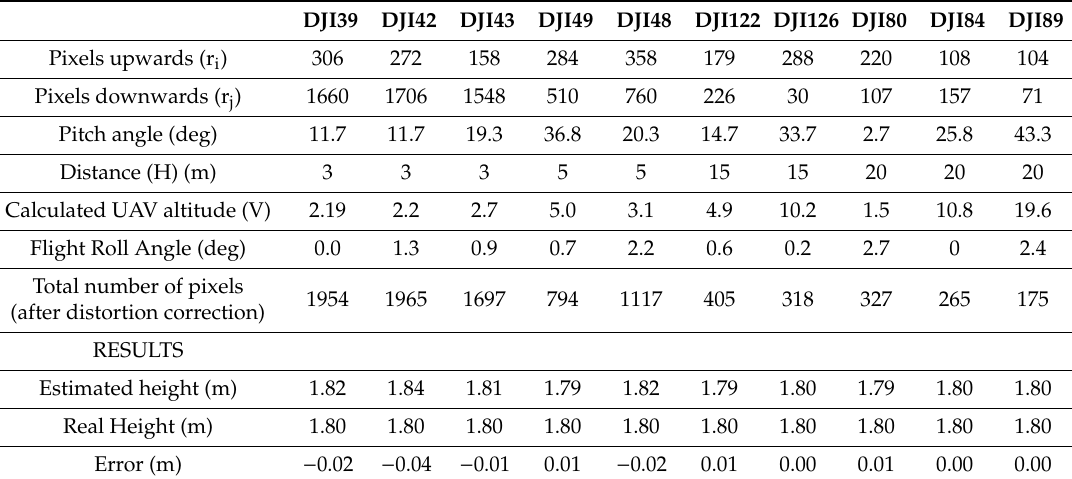
Figure 11. An example of a still image acquired with DJI Phantom 4 PRO with image principal point (visualized in the picture with a blue cross) located over the pole. The number of pixels spanning upward (104) and downward (71) from the image principal point were measured manually on screen. (Source: Personal collection). Table 2. Data collected during Field Test 1 and